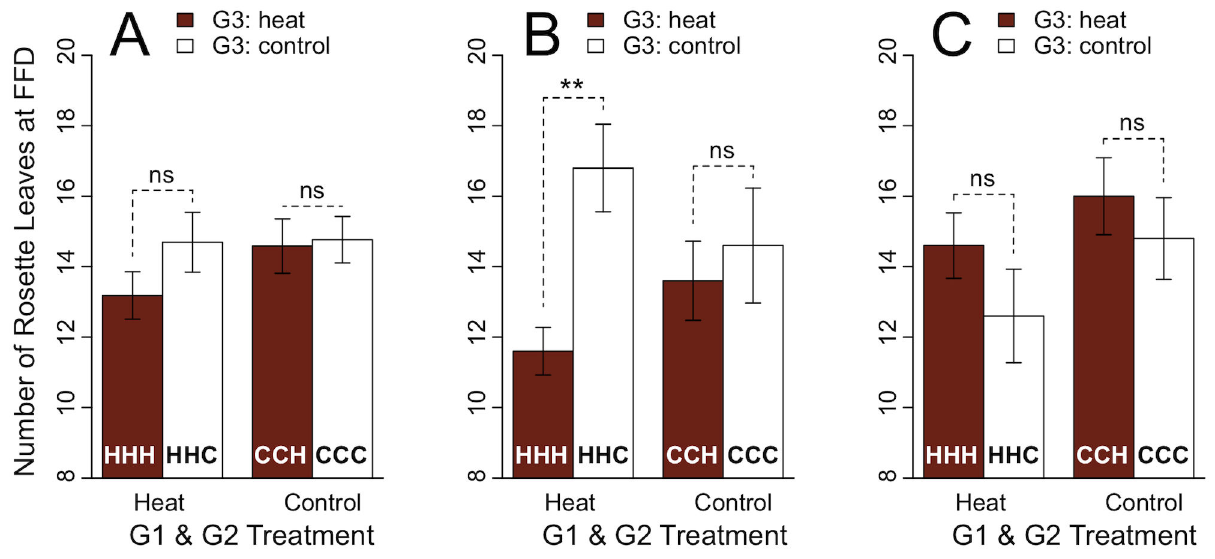
Figure 6. Transgenerational effects of heat on rosette leaves at FFD in genotype Cvi indicate diversified bet-hedging. A: Entire data-set. No differences in number of rosette leaves at FFD were found between G3 treatments when plants experienced the same ancestral treatment. B: For each G1G2 × G3-treatment combination the five plants with the highest silique number were chosen. In plants with ancestral heat treatment, number of rosette leaves differed significantly between G3 heat (HHH) and G3 control (HHC) treatment. When plants were control treated in G1 and G2, no differences were found between G3 treatments. C: For each G1G2 × G3-treatment combination the five plants with the lowest silique number were chosen. No differences in numbers of rosette leaves were found between G3 plants when plants experienced the same ancestral treatments.